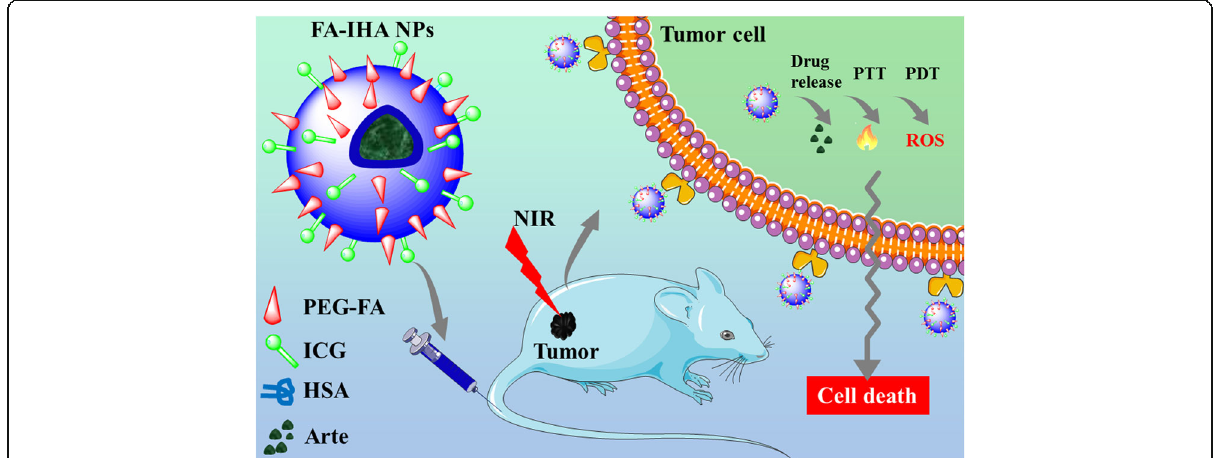
Fig. 1 Schematic representation of FA-IHA NPs use for imaging-guided tumor-targeted combinational photo-chemo therapy in vitro and in vivo